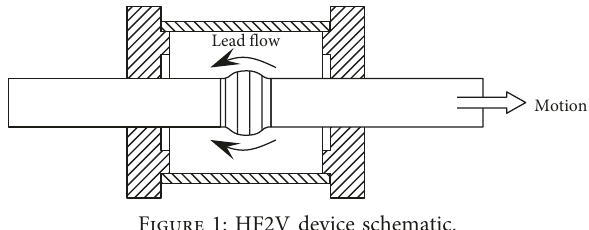
Figure 1: HF2V device